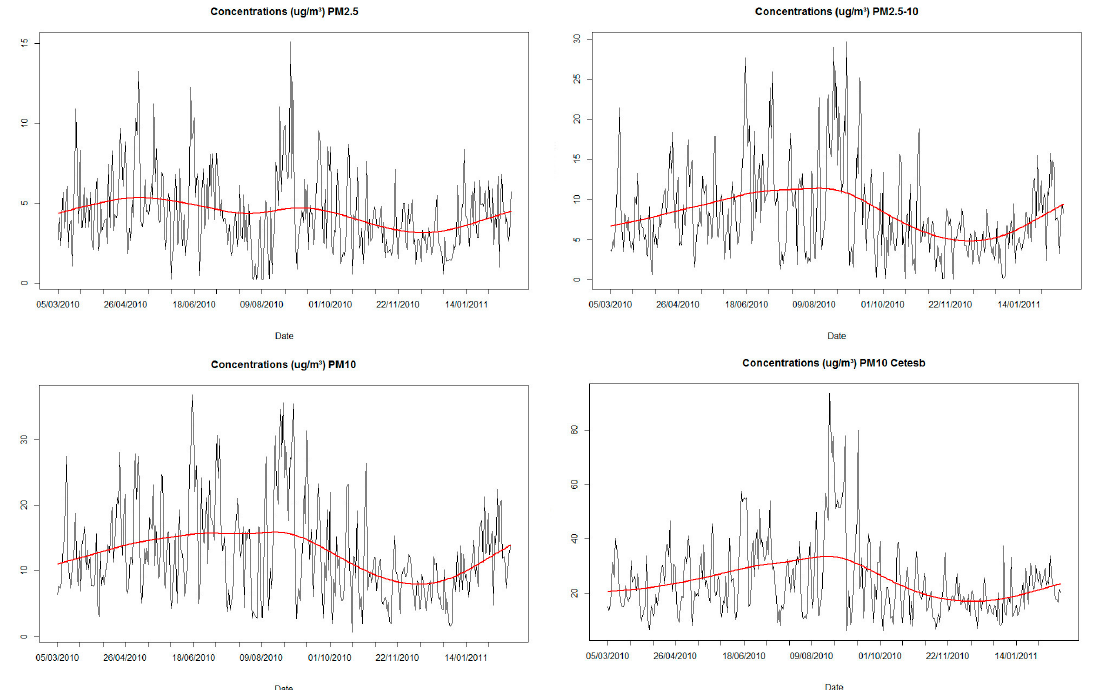
Figure 1. The 24-hour concentrations of pollutants, in µ g/m 3 , as measured by the National Institute for Space Research (Instituto Nacional de Pesquisas Espaciais—INPE) and CETESB monitoring systems. Line, smoothing spline with 6 degrees of freedom.